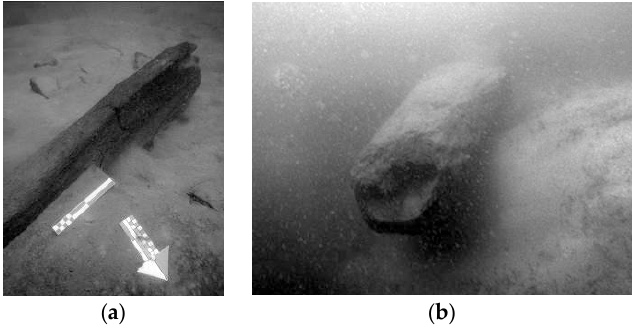
Figure 17. Partially processed trunks found during underwater surveys in Lago Tramonto, Gambulaga, Portomaggiore (FE, Italy): ( a ) A trunk cut to its maximum length with metrical references; ( b ) A trunk, partially excavated inside (photo by Giovanna Bucci).